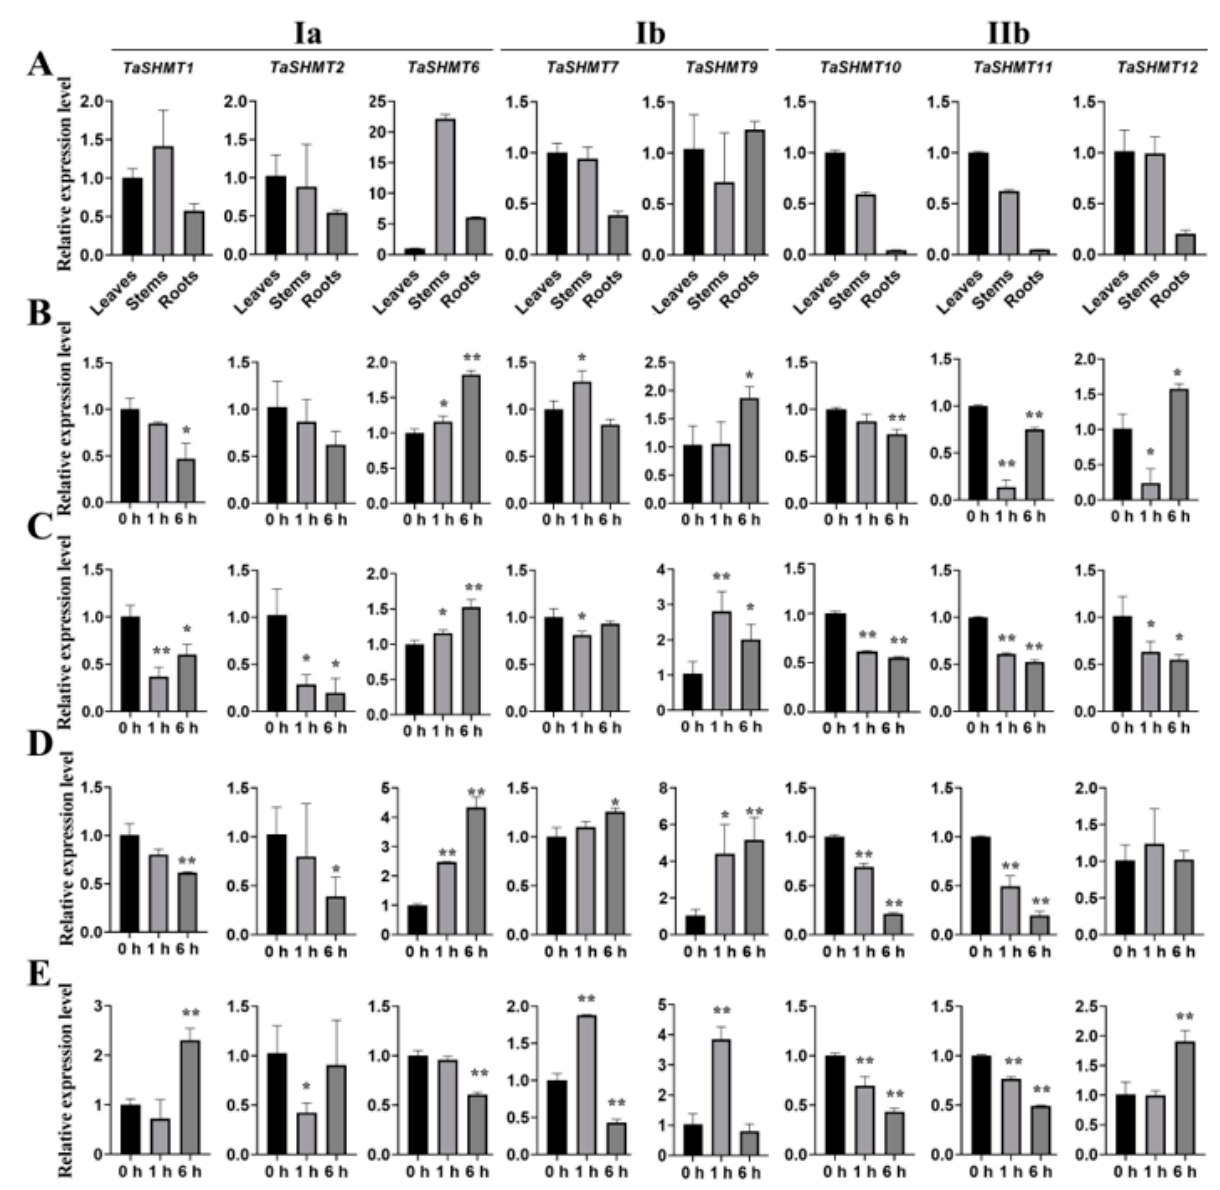
Figure 6. Expression patterns of TaSHMT genes in different tissues and in response to abiotic stress in wheat. ( A ) Expression levels of TaSHMT genes in the roots, stems, and leaves during wheat seedlings stage. ( B – E ) Expression patterns of TaSHMT genes in response to PEG (polyethylene glycol) ( B ), NaCl ( C ), cold ( D ), and heat ( D ) treatments determined by real-time PCR. The expression level of the wheat actin gene was used as the internal control to standardize the RNA samples for each reaction. The values are the mean ± SE (control as 1). Asterisk indicates significant differences compared with control based on Student’s t -test (* p < 0.05 and ** p < 0.01).